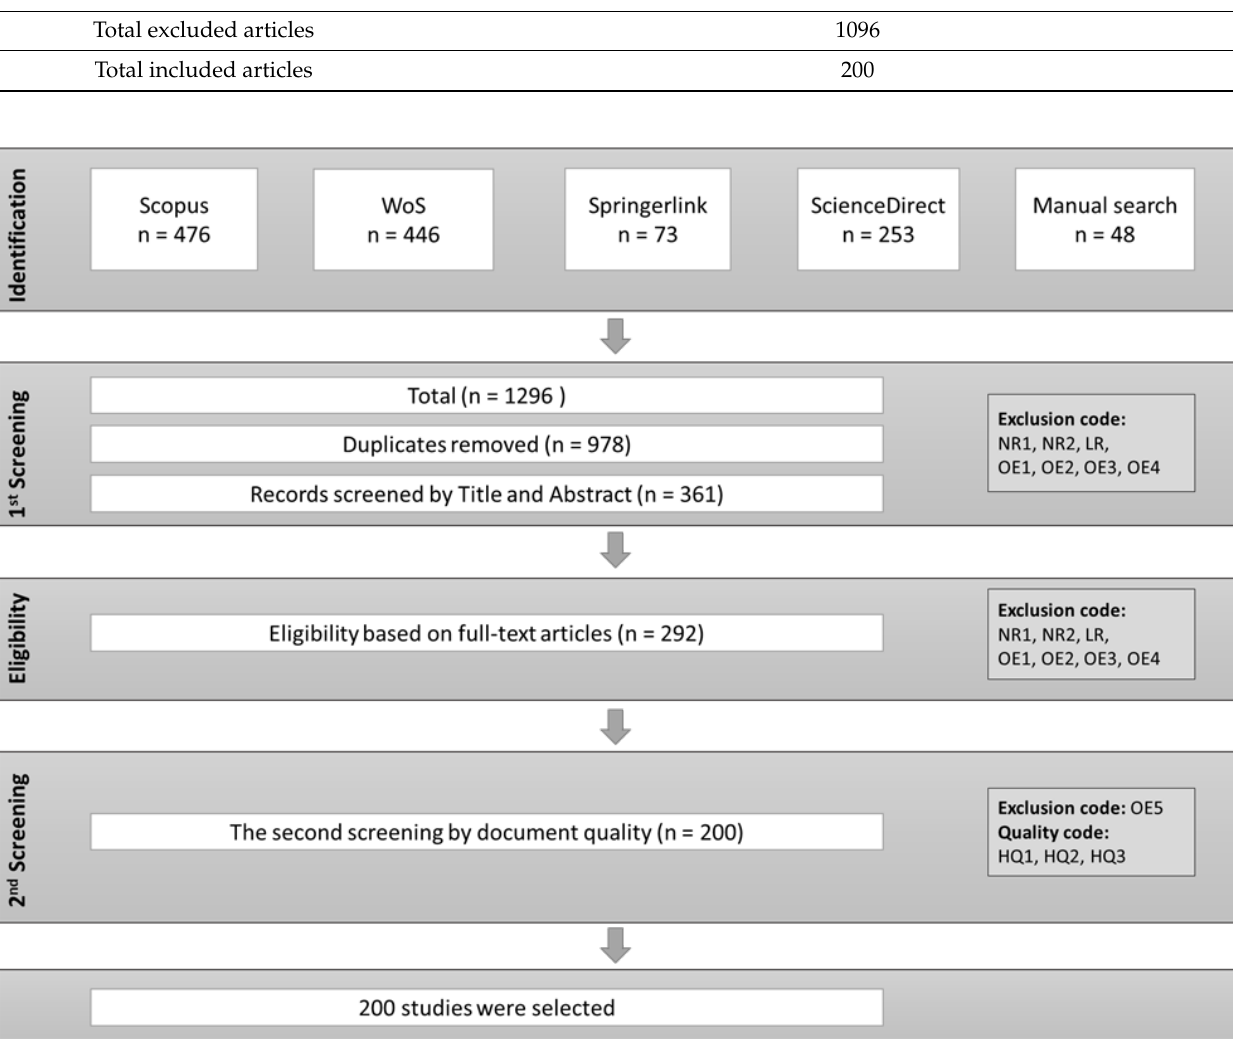
Figure 4. Search results following PRISMA flow chart adapted from [31].